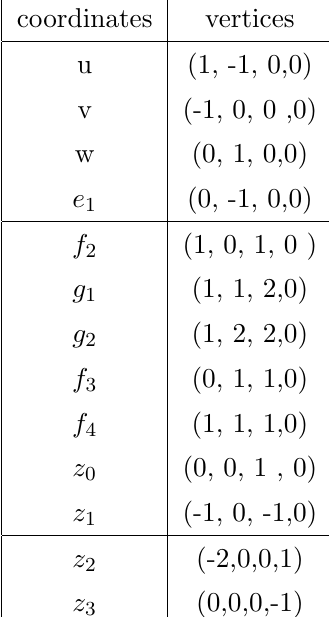
0 = d 3 d 5 (cid:0) d 1 d 7 = d 7 = 0; non-Kodaira singularity with 16 10 . (cid:0) 1 = 4 1 = 4 1 = 2